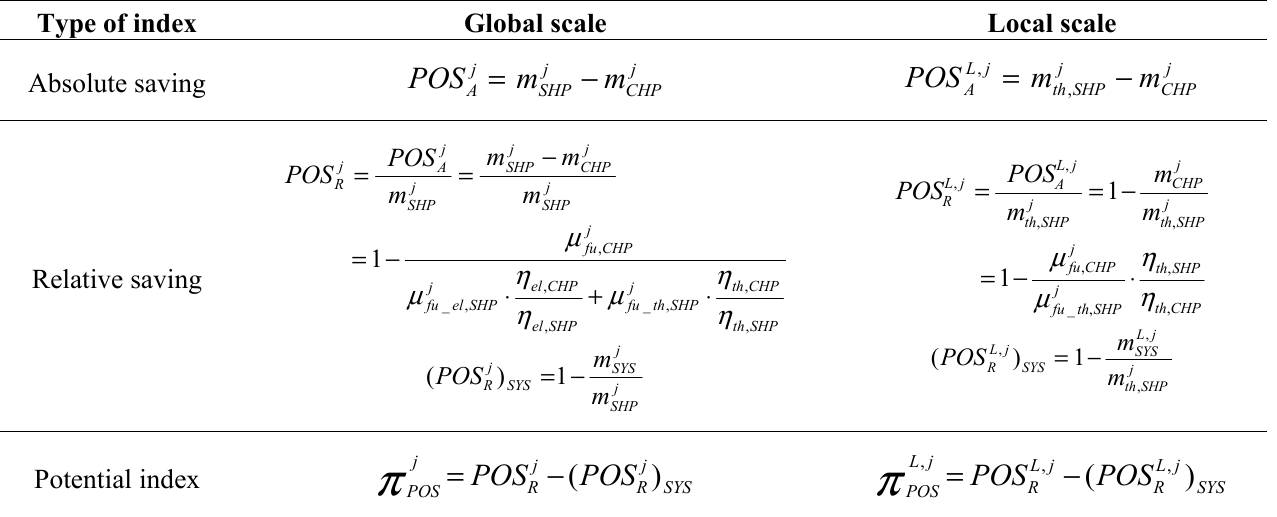
Table 2. The main equations for the evaluation of the global and local pollutant savings. Type of index Global scale Local